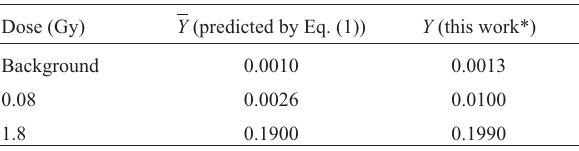
Table 2 - Comparison between estimated and experimental frequencies of unstable CA.